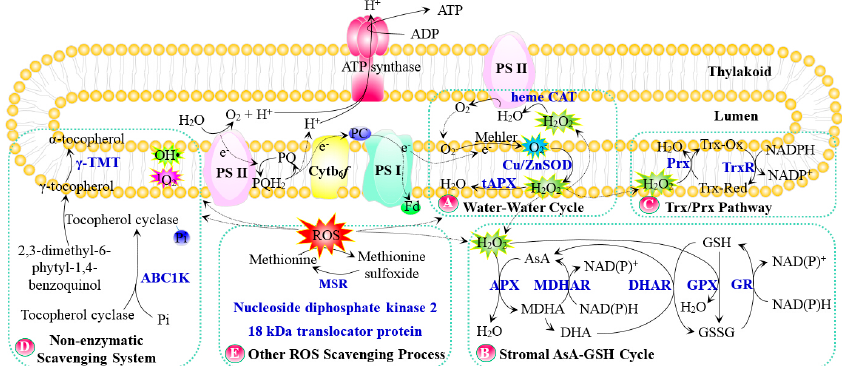
Figure 1. Schematic presentation of ROS scavenging pathway in chloroplasts. ( A ) Water–Water cycle;